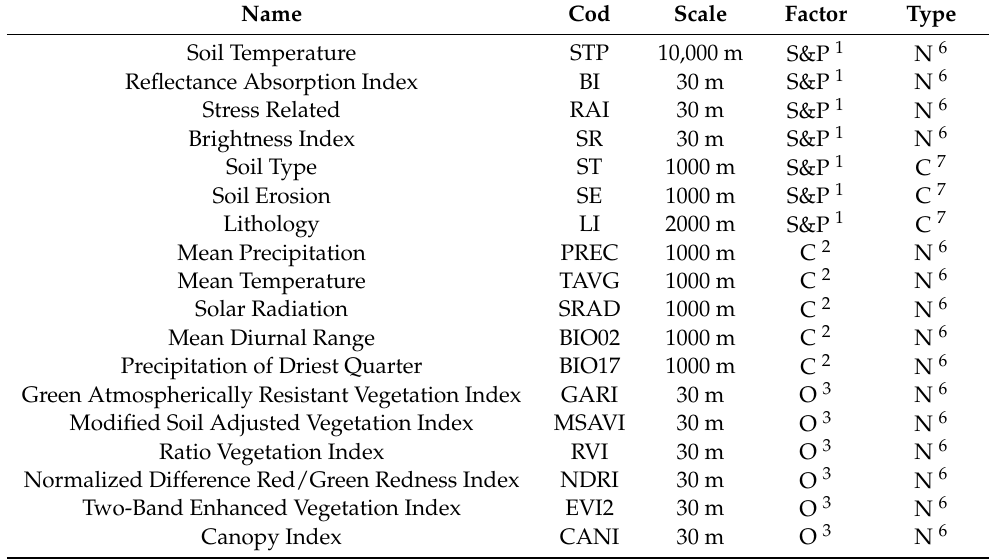
Table 1. List of all environmental